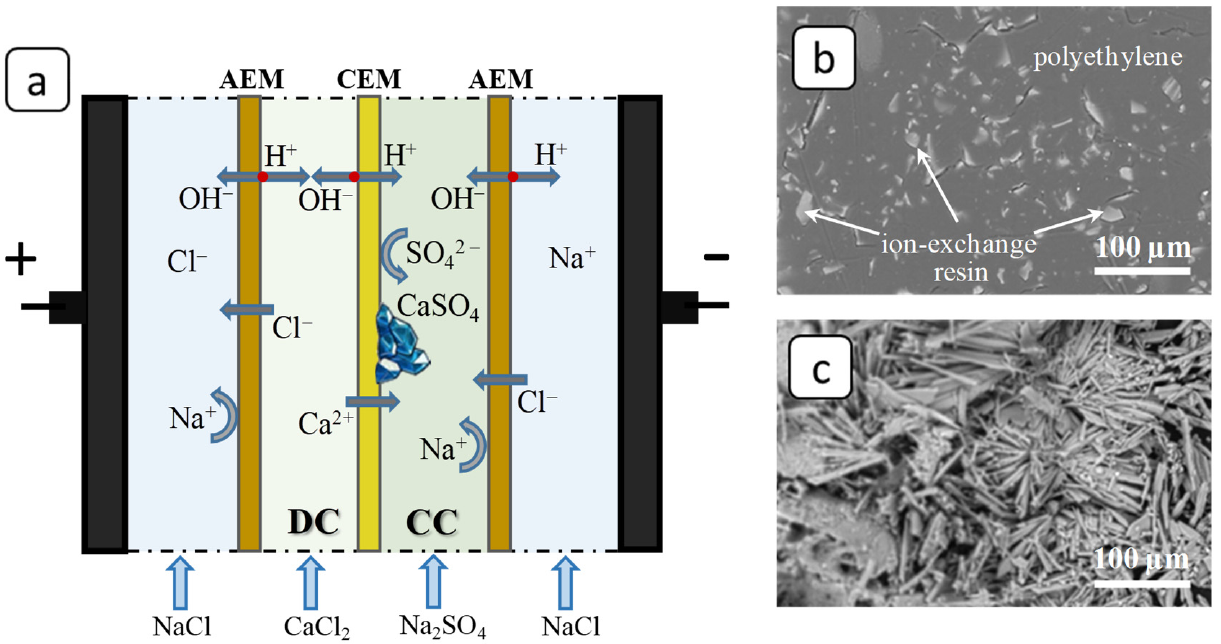
Figure 3. The scheme of ion fluxes in the electrodialysis cell ( a ) and SEM images of the CEM surface facing the concentration compartment before ( b ) and after ( c ) the blank experiment.